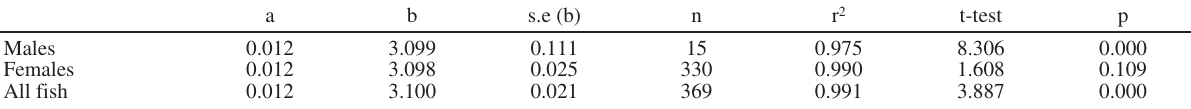
Table 1. – Parameters of the length-weight relationships for females, males and all fish (males, females, immatures and hermaphrodites) of Spondyliosoma cantharus in the Gulf of Tunis . All three relationships were significant (ANOVA, p<0.001). The isometry was tested by